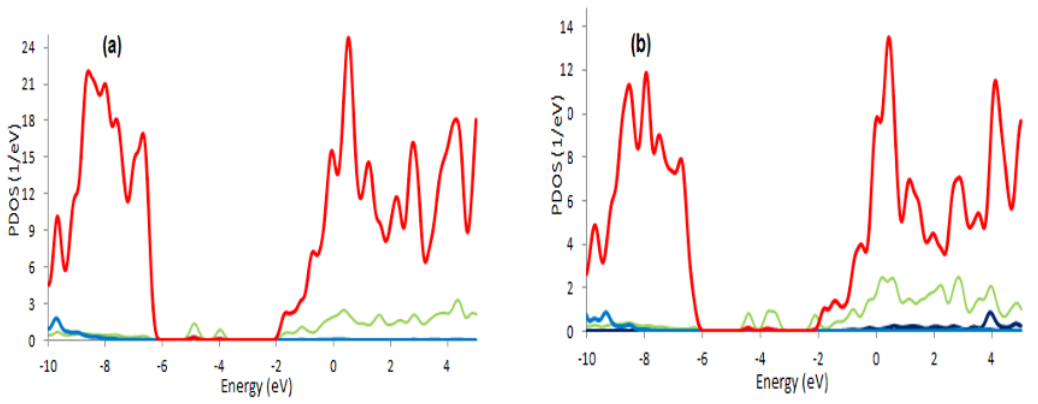
Figure 5. Curve of partial electronic density of states (PDOSs) for (a) model.1, and model.2 of AlNNTs. In both models, the light green line relates to Al atomsdirectly connected to O atoms, the blue line belongs to O atoms, the dark blue line relates to H atoms (only in the model.2) and the red line is for reminded atoms in each case of